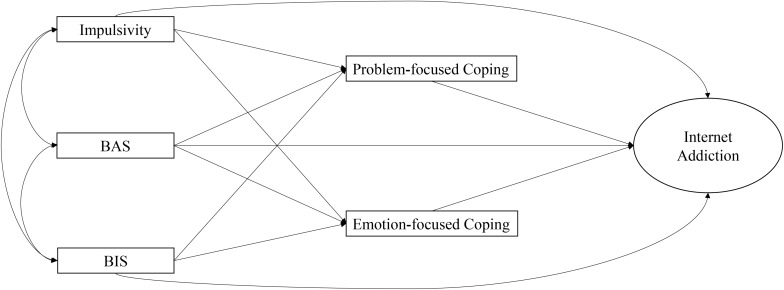
The supposed model.